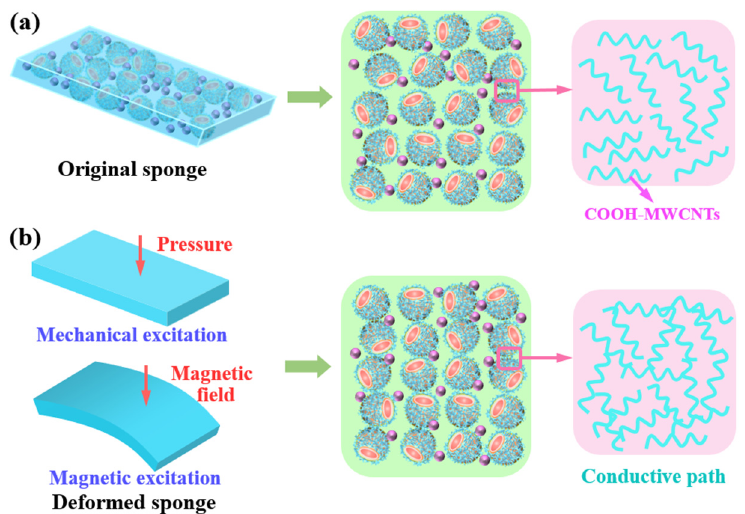
Figure 10. Schematic illustration of the stimuli-sensitive mechanism. ( a ) Microstructure of sample and conductive MWCNTs networks in the initial state. ( b ) Deformation of sample and conductive MWCNTs networks under various